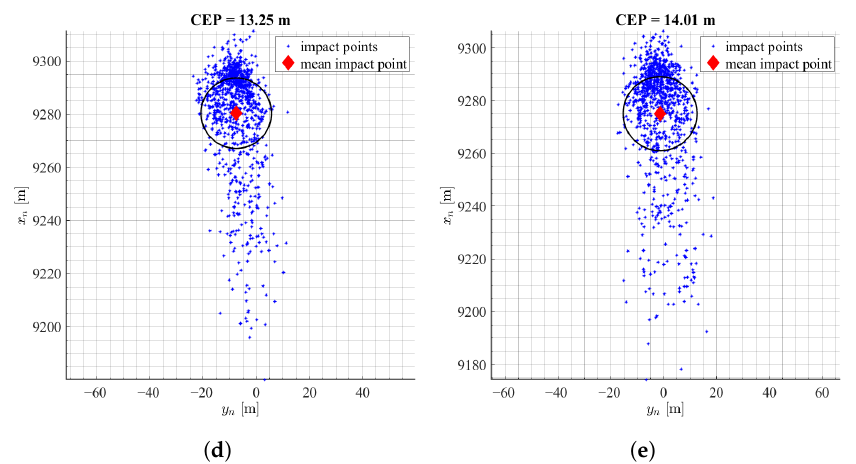
Figure 9. Results of landing point dispersion with uncertainties of initial conditions: ( a ) no control, ( b ) mPNG, ( c ) mPNG + IMU, ( d ) MCCA, ( e ) MCCA +